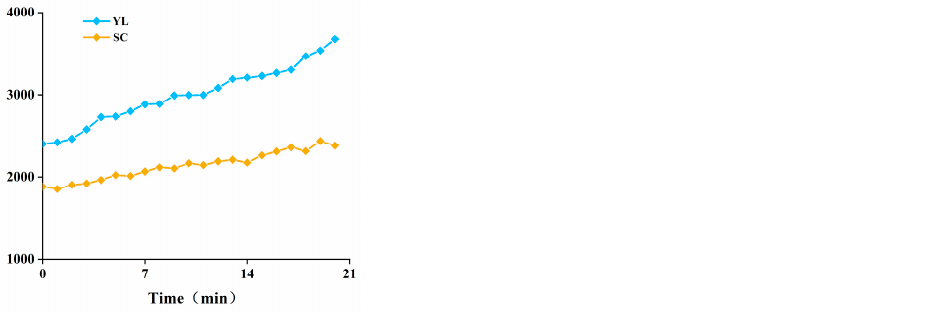
Figure 2. Comparison of the intracellular ROS levels between the SCs and YL in Aureobasidium pul- lulans NG. The data represent the means ± standard deviations of triplicate